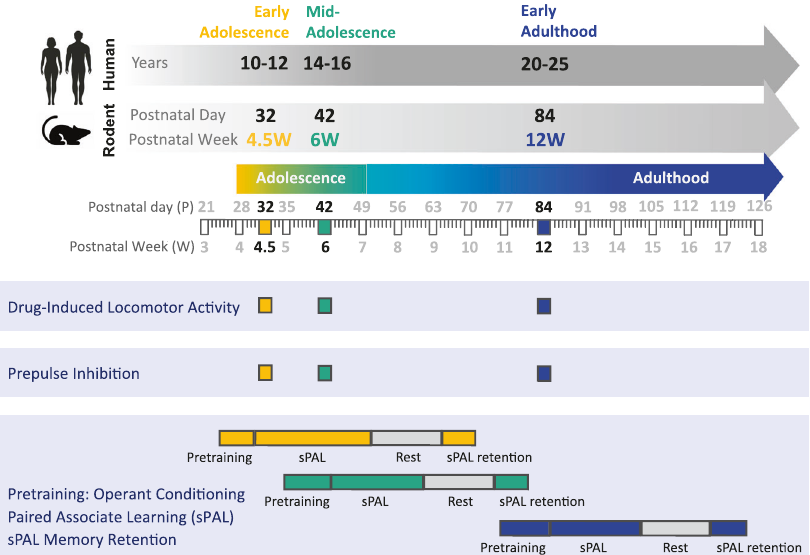
Fig. 1 Schematic of the experimental timeline to capture behavioral trajectories during adolescence and adulthood in male and female mice on distinct cognitive tasks. In humans, early adolescence is ∼ 10 – 12 years of age, mid-late adolescence ∼ 14 – 16 years of age, and early adulthood ∼ 20 – 25 years of age. Aligning this, the behavior of mice at two adolescent ages (early 4.5 W, mid 6 W) and adulthood (12 W) was measured using drug-induced locomotor hyperactivity, prepulse inhibition, and a two-object simple paired associate learning (sPAL) touchscreen task which involved pretraining to acquire operant conditioning, sPAL training, and sPAL memory retention testing following a rest